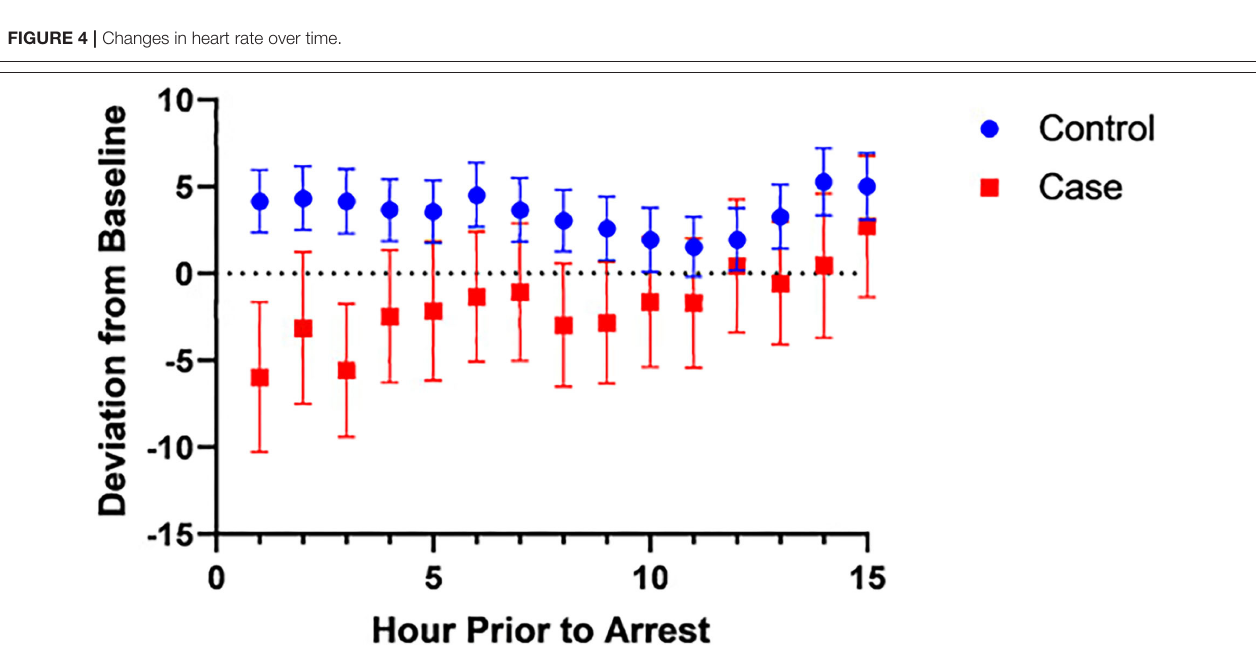
FIGURE 5 | Changes in diastolic blood pressure over